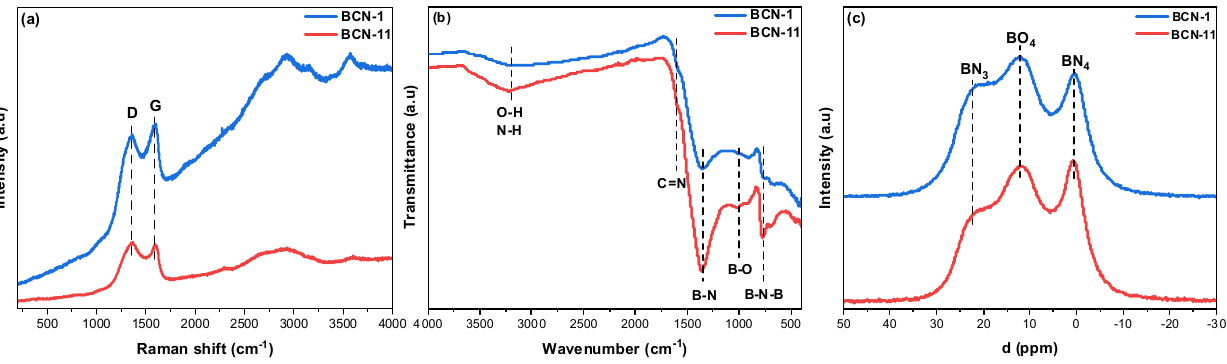
Figure 5. ( a ) Raman spectra of BCN − 1 and BCN − 11; ( b ) FTIR spectra of BCN − 1 and BCN − 11; ( c ) 11 B MAS NMR spectra of BCN − 1 and BCN − 11.